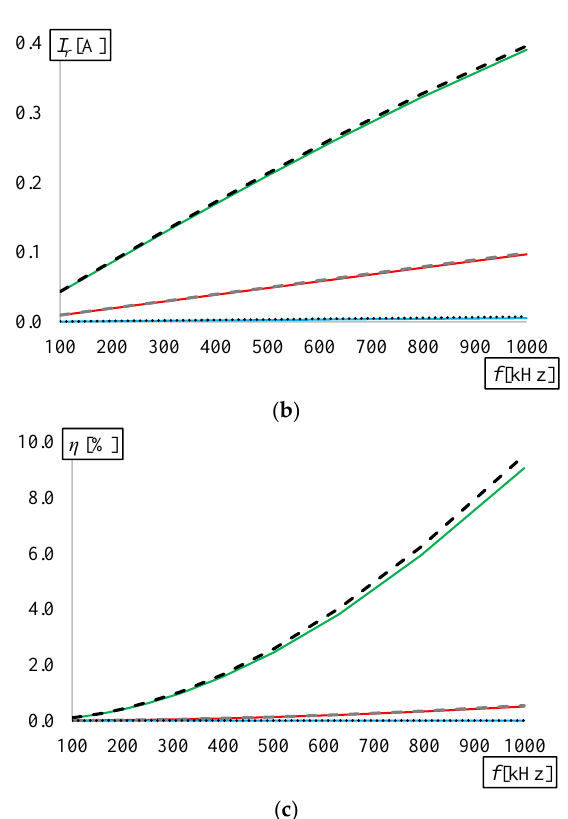
Figure 8. Results for the case r c = 5 mm, n c = 10: ( a ) transmitter current, ( b ) receiver current, and ( c ) power transfer efficiency.